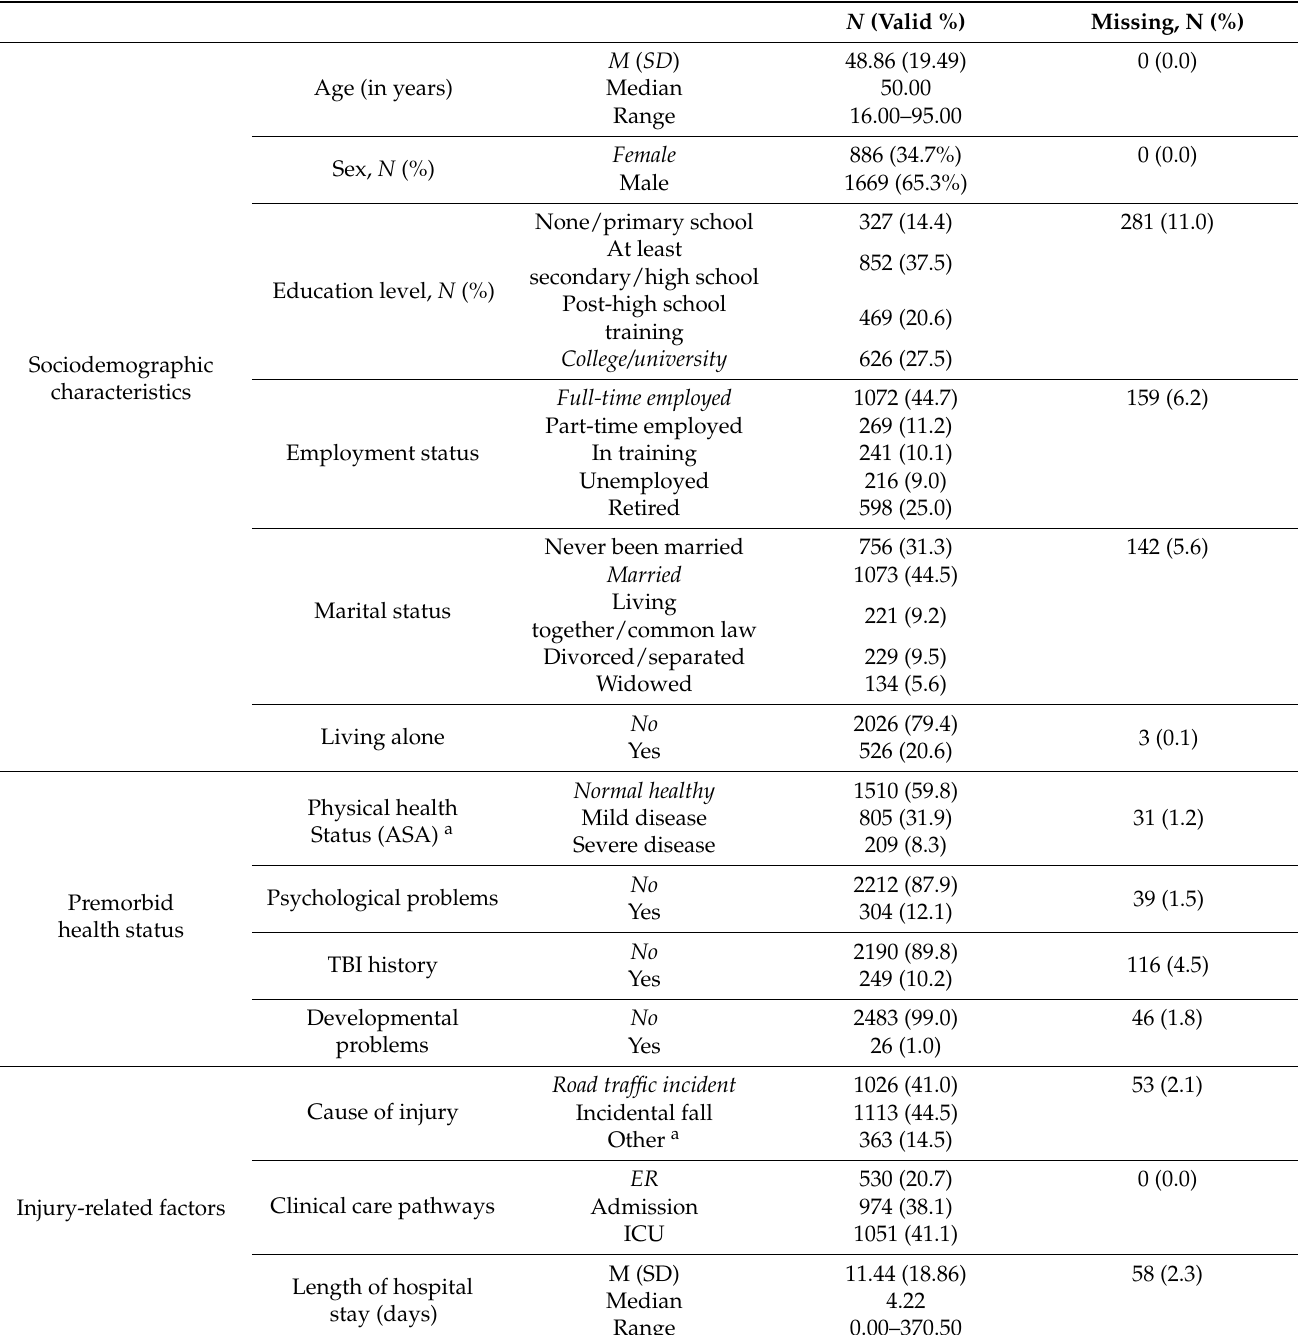
Table 1. Sociodemographic, premorbid, and injury-related characteristics of the sample ( N = 2555). N (Valid %) Missing, N